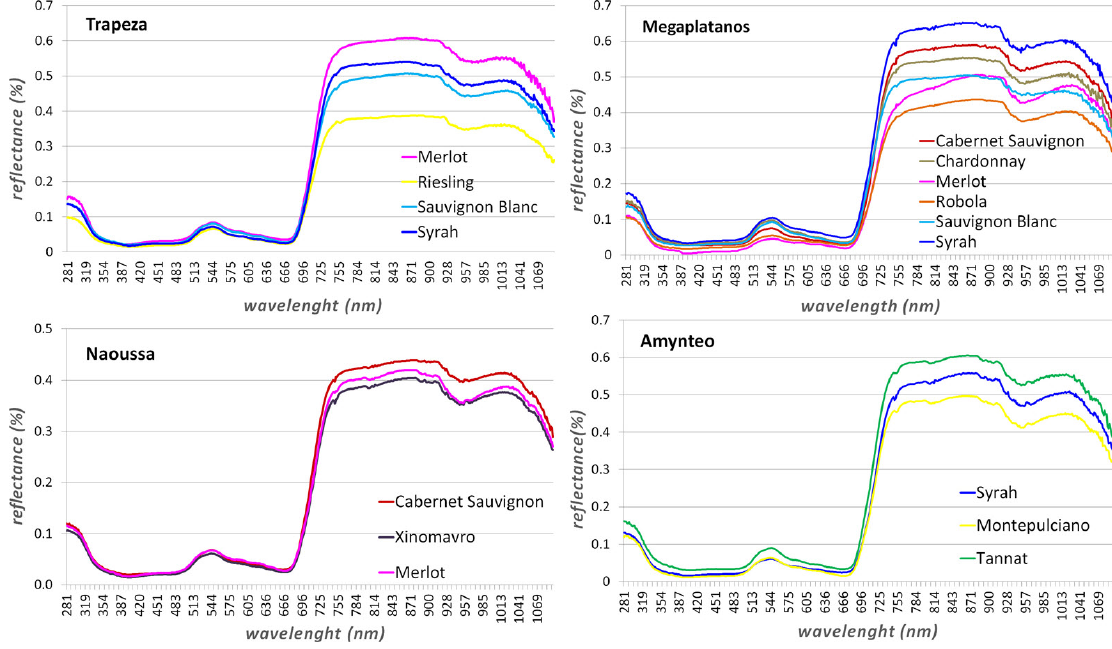
Figure 6. The in situ reflectance spectral signatures of different varieties for the four study